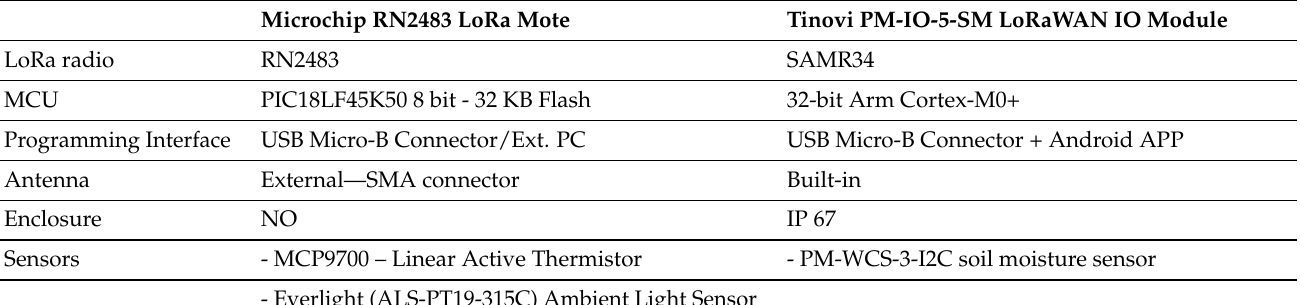
Table 2. Features of the two EDs used in this